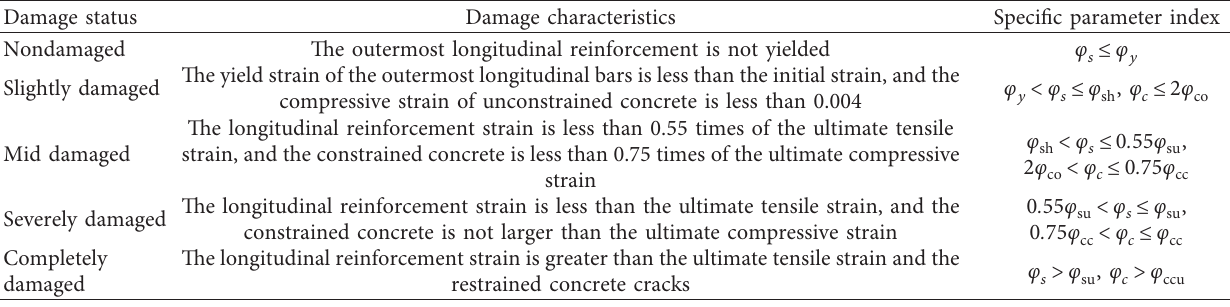
Table 1: Characteristics of the curvature ductility index.